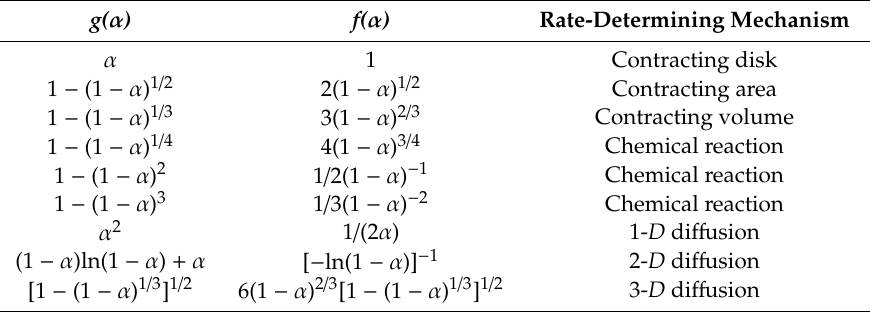
Table 1. Reaction mechanisms during the solid-state process